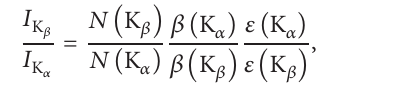
and 𝜎 production cross K 𝛼 K 𝛽